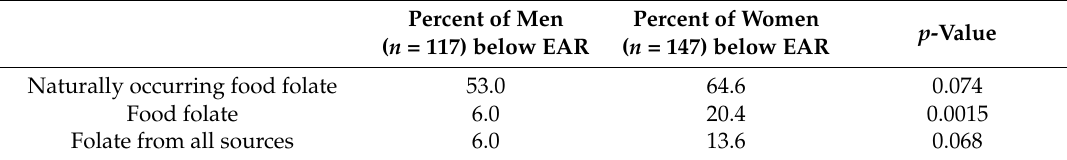
Sex differences in the percentage of participants below the Estimated Average Requirement